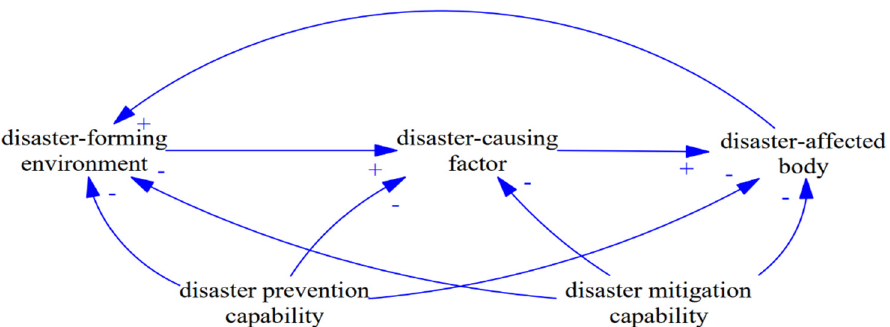
Figure 1. Overall mechanism of site system model under natural disasters.